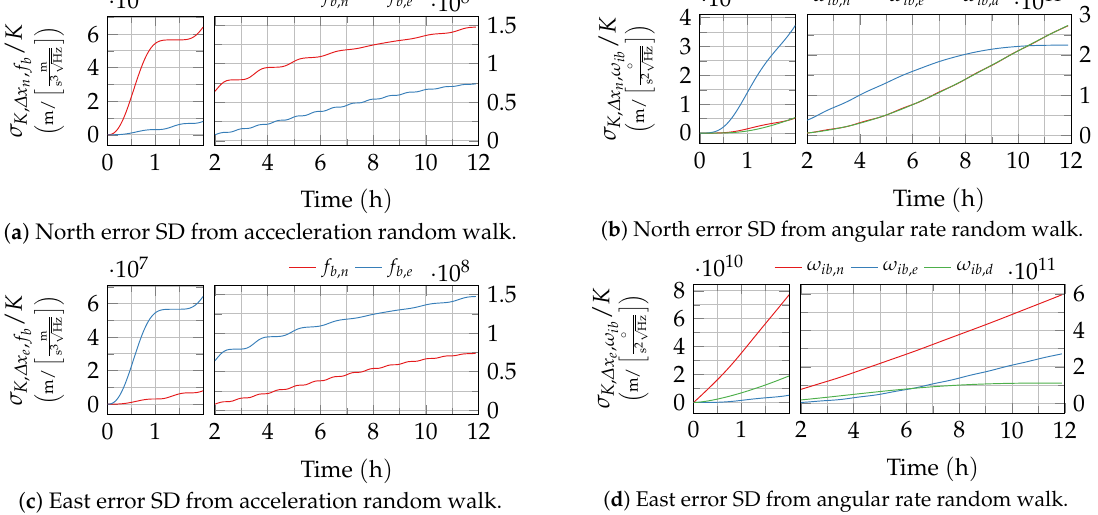
( a ) North error SD from accecleration random walk. ( b ) North error SD from angular rate random walk.